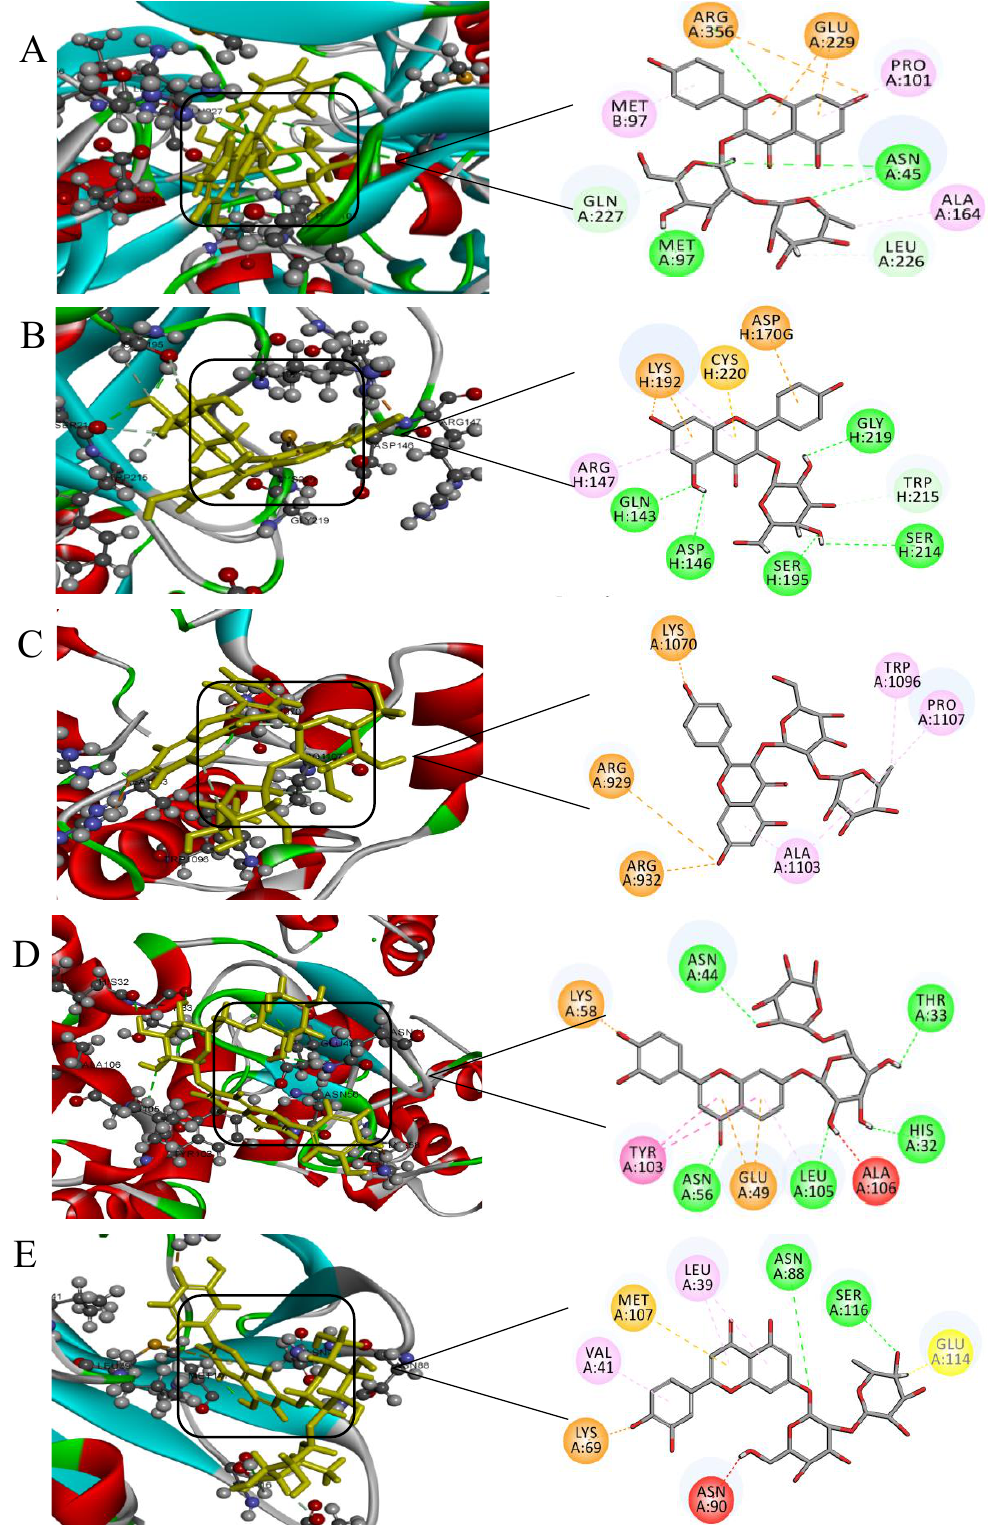
Figure 4. The complexe docking diagrams of the flavonoids with the different proteins. ( A ) the flavonoid (6)/SPI (7S), ( B ) the flavonoid (2)/SPI (7S), ( C ) the flavonoid (4)/BSA ( D ) the flavonoid(3)/ α -La, ( E ) th flavonoids(5)/ β-Lg.